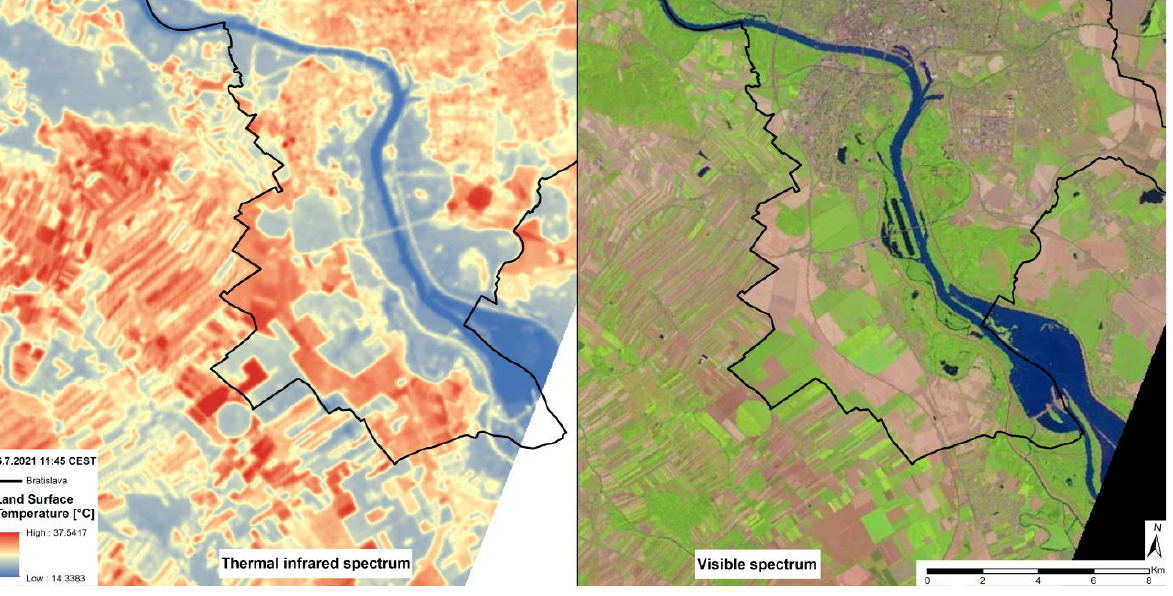
Figure 8. Surface temperatures in the area of Sysľovské polia (after the harvest) on the satellite pictures, 9 September 2021, about 11:45CEST (on the left: thermal infrared spectrum, on the right: Visible spectrum) (Landsat-8 image courtesy of the U.S. Geological Survey).